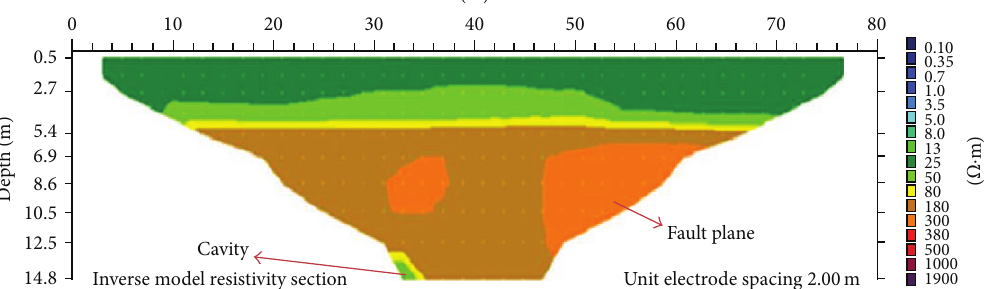
Figure 6: 2D resistivity image of first line showing cavity and fault plane.